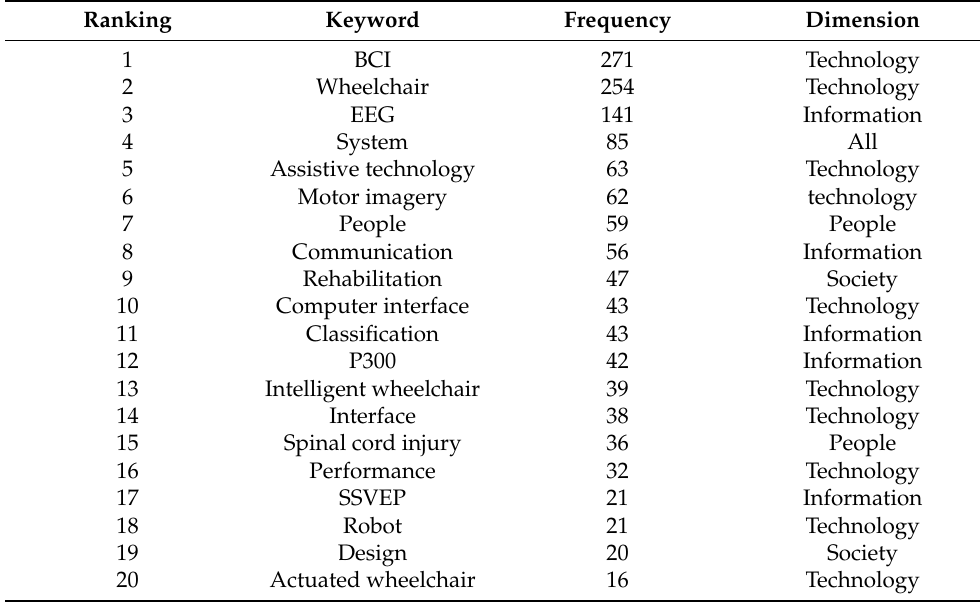
Table 8. Top 20 keywords in terms of their frequency in EPW HMI methodology research.